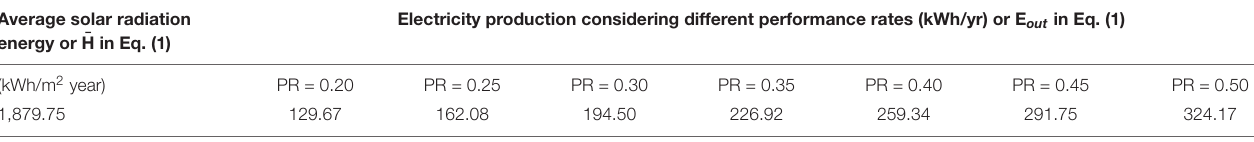
TABLE 10 | Hydrogen production (kg/year) using the proposed system at different performance rates. PR =